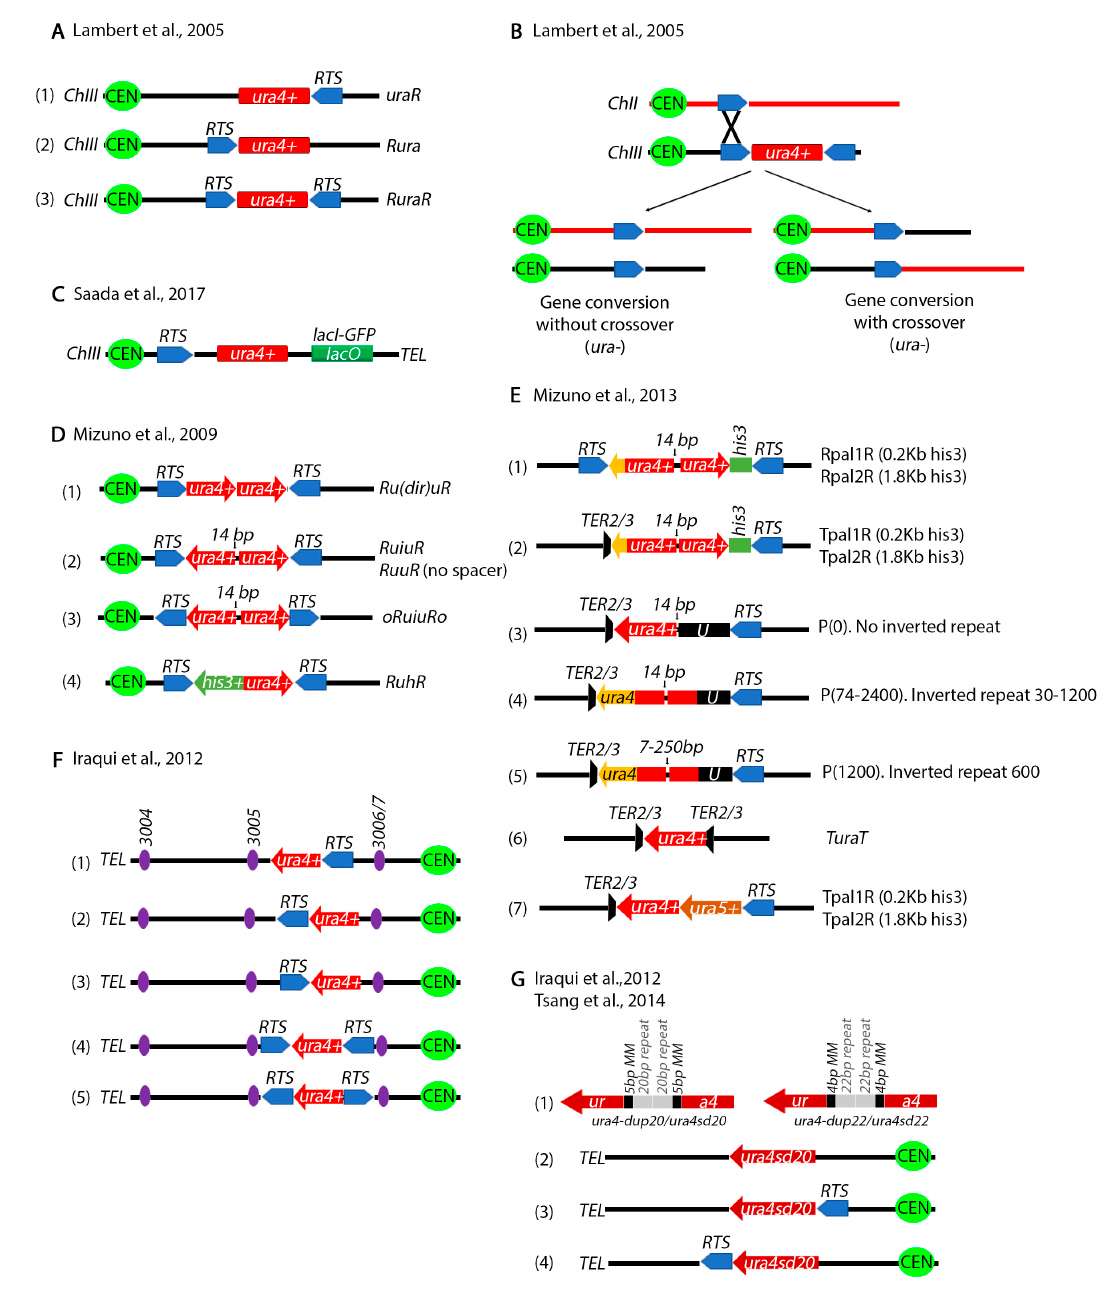
Figure 4. Assays to study gross chromosomal rearrangements at inverted repeats. ( A ) An assay to study fork stalling at repetitive elements. (1) The RTS1 pause site was placed on the right of a functional ura4 + gene ( uraR ), (2) left ( Rura ) or (3) both sides ( RuraR ). Fork stalling was assayed using pulse field gel electrophoresis (PFGE). ( B ) Chromosomal rearrangements of constructs in ( A ) can occur by two mechanisms: gene conversion without crossover and gene conversion with crossover. In both cases there is a recombination event between the RTS1 site next to the ura4 + cassette and the endogenous RTS1 at the MAT locus on Ch.II. Both types of events result in loss of ura4 + . ( C ) Modification of construct in ( A ) to monitor chromosomal dynamics by fluorescence microscopy. A LacO array was placed on the telomere side of the RTS1 / ura4 + cassettes. ( D ) Repetitive elements constructs to study chromosomal rearrangements. (1) RTS1 cassettes were placed on both sides of two directional ura4 + repeats ( Ru(dir)uR ). (2) RTS1 was placed on both sides of inverted ura4 + repeats spaced by 14 bp of unique sequence ( RuiuR ). A construct without the 14bp spacer was also made ( RuuR ) (3) In oRuiuR